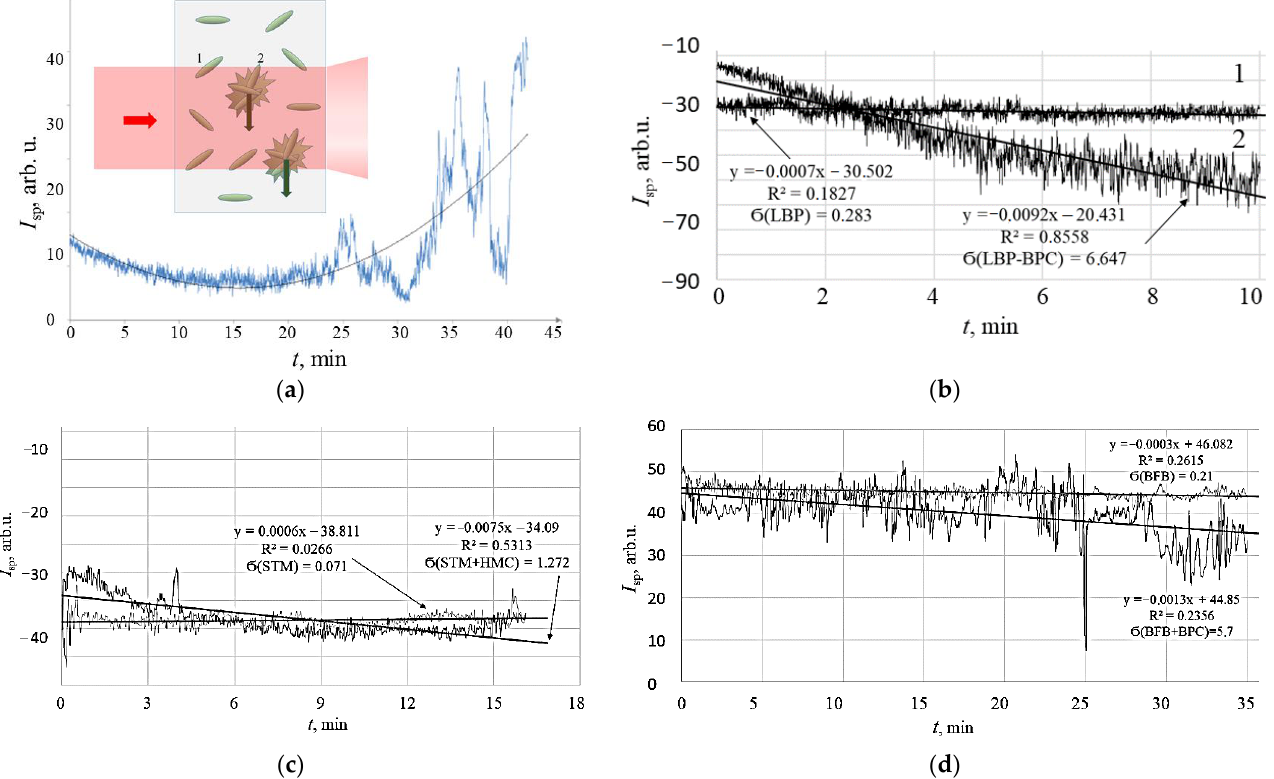
Figure 10. Time dependence of speckle fluctuation kinetics, I sp for suspensions of microorganisms exposed to antibiotics, observed in a planar cell, d = 1 mm. ( a ) Schematic representation of bacterial agglomerates migration direction in the cell (insert), and observation of E. coli M-17 suspension exposed to ceftriaxone; ( b ) Lactobacillus plantarum (LBP), strain 8P-A3 (1), 10 7 , LBP with benzyl penicillin (BPC) (2); ( c ) Stenotrophomonas maltophilia (STM), 10 7 CFU/mL (1), STM with gentamicin (GMC) (2); and ( d ) Bifidobacterium bifidum (BFB) (1), 10 7 CFU/mL, BFB and ceftriaxone (CTA) (2). Standard deviation data are calculated for time ranges 5 to 10 min. Table 2. Observation of speckle fluctuations parameters for suspensions of microorganisms with and without antibiotics.